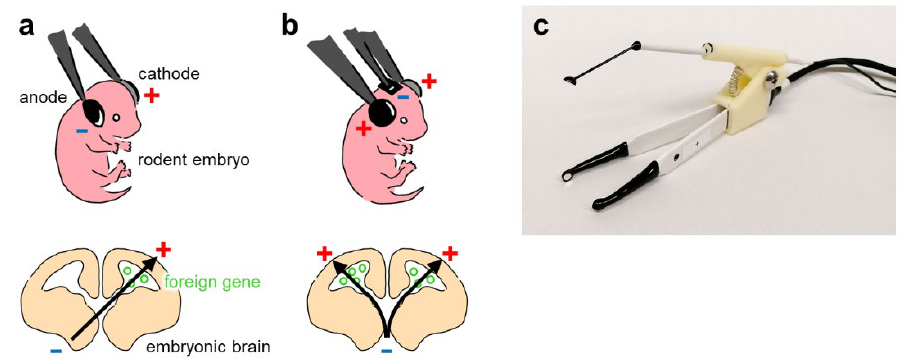
Figure 3. Double- and triple-electrode probe techniques for in utero electroporation. ( a ) Top: Elec- troporation using a double-electrode probe, with the anode and cathode indicated in blue and red, respectively. Bottom: The black arrow indicates the flow direction of plasmid DNA as DNA is nega- tively charged. ( b ) Top: Electroporation using a triple-electrode probe. Bottom: The triple-electrode probe technique enables the transfer of plasmid DNA into both the right and left ventricular zones. ( c ) Photograph of our custom-made tripolar-electrode probe and handle.